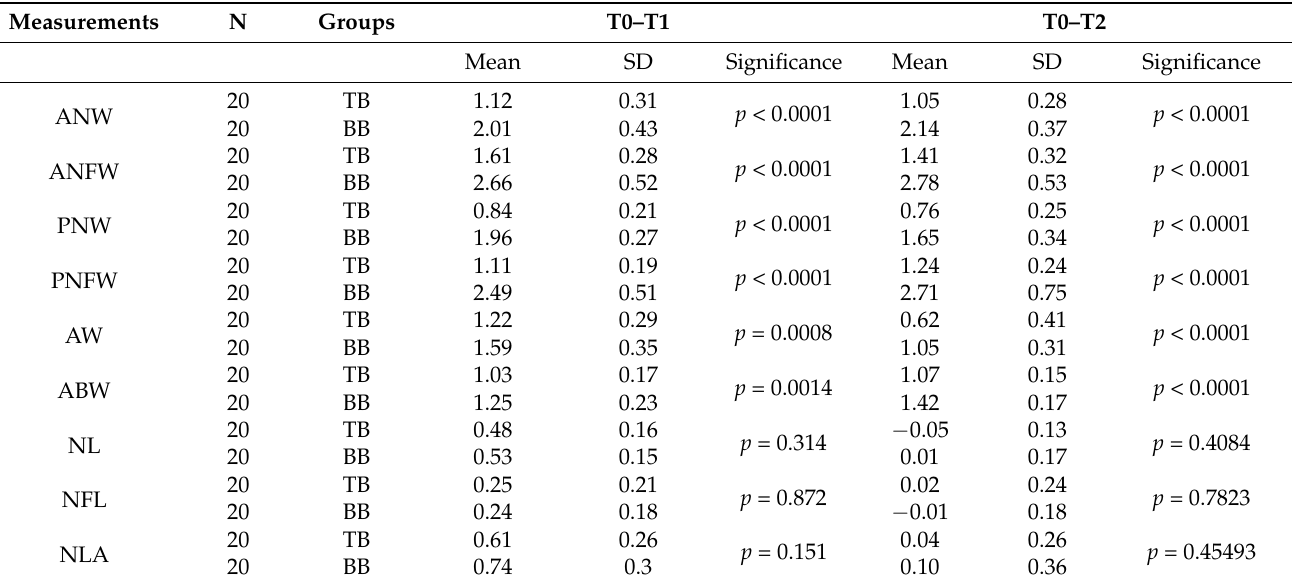
Table 4. Comparisons of mean changes obtained after 6 months (T0–T1) and one year after treatment (T0–T2) between TB and BB groups.